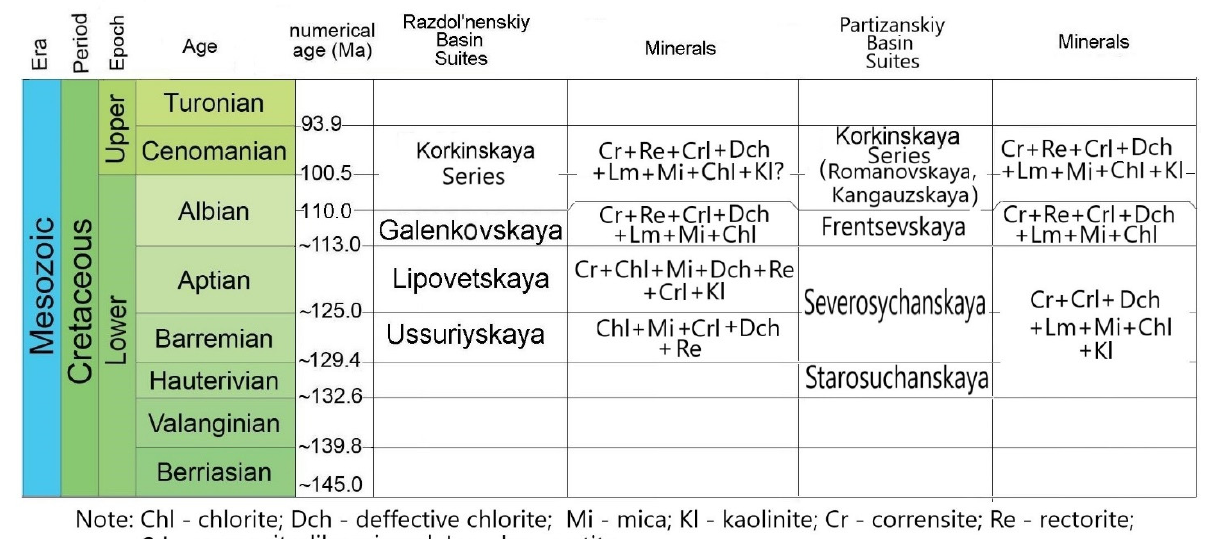
Figure 2. Authigenic minerals identified in Cretaceous volcanogenic–sedimentary rocks of Southern Primorye. Table 1. Associations of authigenic minerals in the studied volcanogenic-sedimentary rocks of the Southern Primorye.